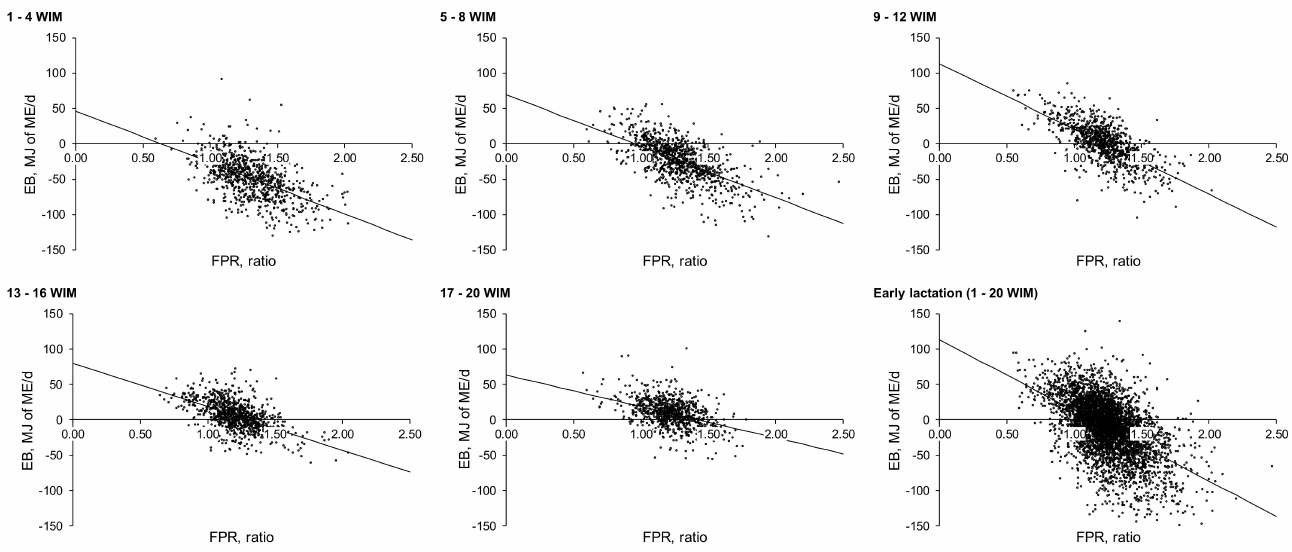
Figure A3. Linear relationships between fat-to-protein ratio in milk (FPR) and daily energy balance (EB, MJ of ME/day) in third lactation Holstein-Friesian dairy cows (1–20 WIM). Mixed regression models for each relationship are presented in Table